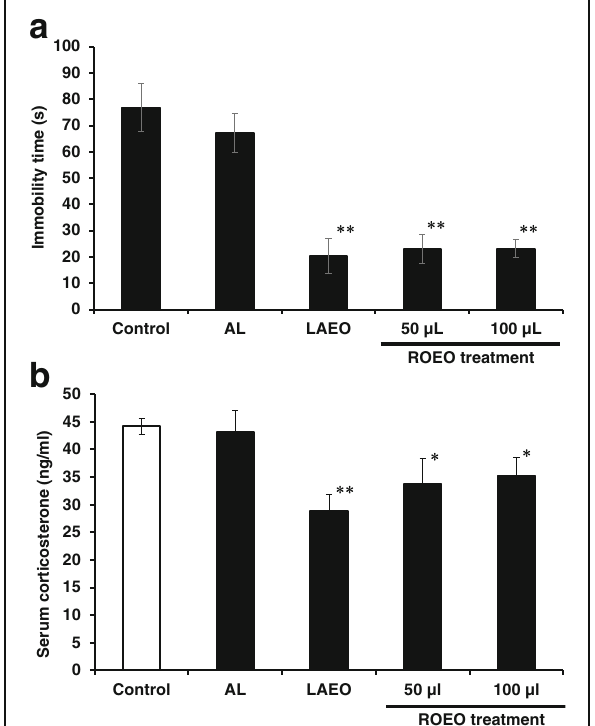
Fig. 1 Effect of Rosmarinus officinalis essential oil (ROEO) on